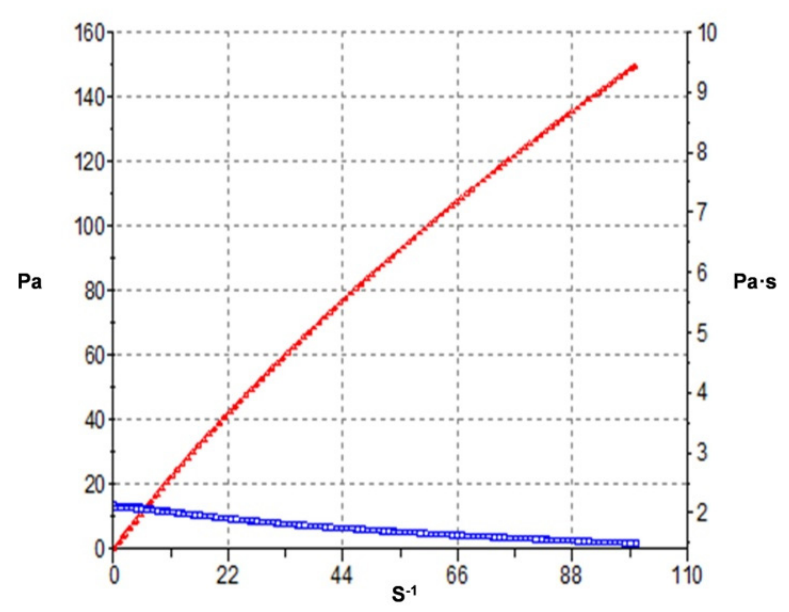
Figure 3. Rheological profile of KT-CTS gel. Blue curve represents the formulation viscosity. Red curve represents the shear stress of the formulation.